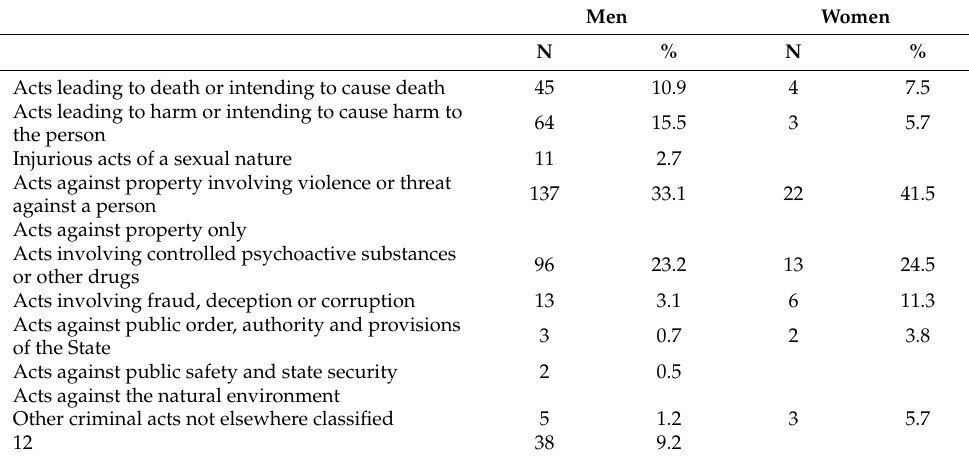
Table 3. Descriptive statistics of criminal categories according to gender.